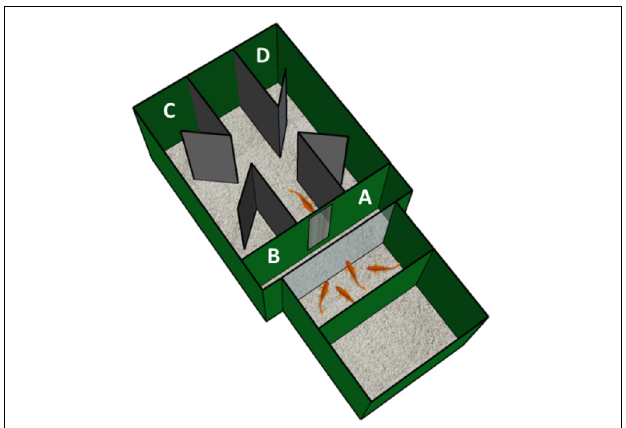
FIGURE 1 | Experimental apparatus. Schematic representation of the experimental apparatus used for the detour task with fish. It is composed of two adjacent glass tanks, covered with dark green plastic material (Poliplak R (cid:13) ): the smaller tank (on the bottom right) housed four adult fish that acted as social attractor for the experimental subject, instead located in the larger tank (on the upper left). Furthermore, the drawing shows the grid through which the experimental subject could observe the goal-object (social stimuli) and the four compartments, placed at the four open ends of the corridor: A and B , the correct compartments, localized close to the grid; C and D , the incorrect compartments, localized on the opposite side of the experimental tank.